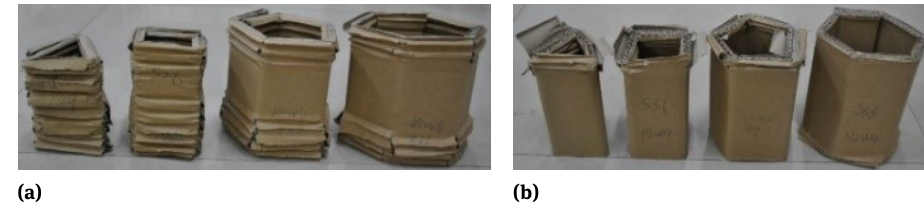
Figure 6: Deformation modes for different cross-sections: (a) X- and (b) Y-direction paper corrugation tubes